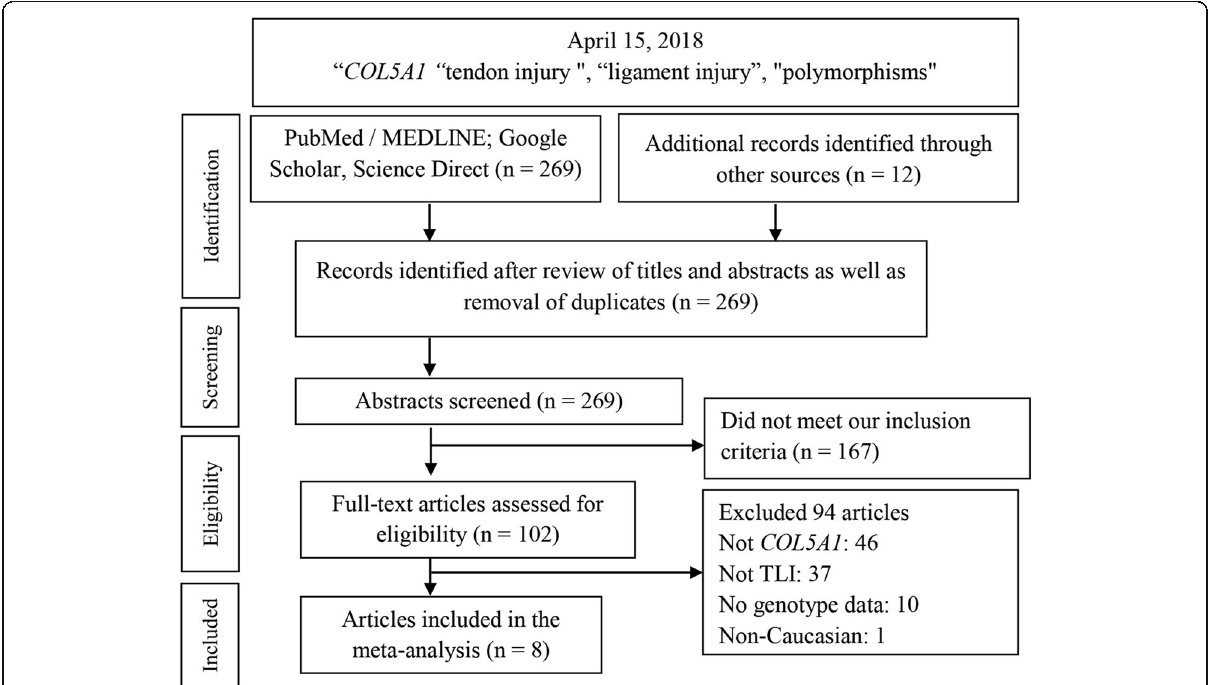
Fig. 1 Summary flowchart of literature search. TLI tendon-ligament